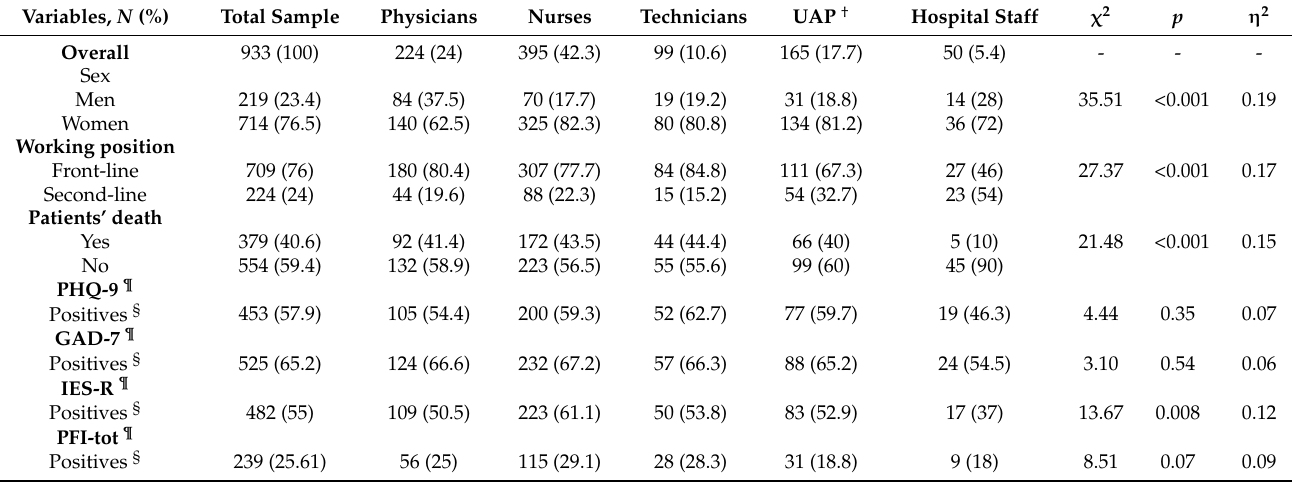
Table 1. Sociodemographic, workload characteristics, and psychological symptoms in the total sample and healthcare professions